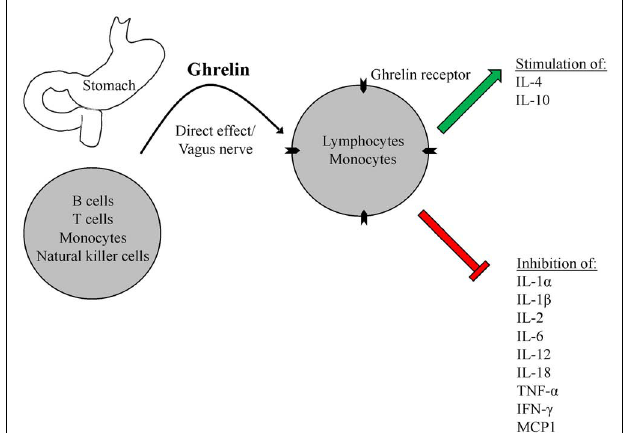
FIGURE 3 | Schematic overview of ghrelin derived from gastric X/A-like cells or immune cells and effect on cytokine production and release from immune cells under immune challenge